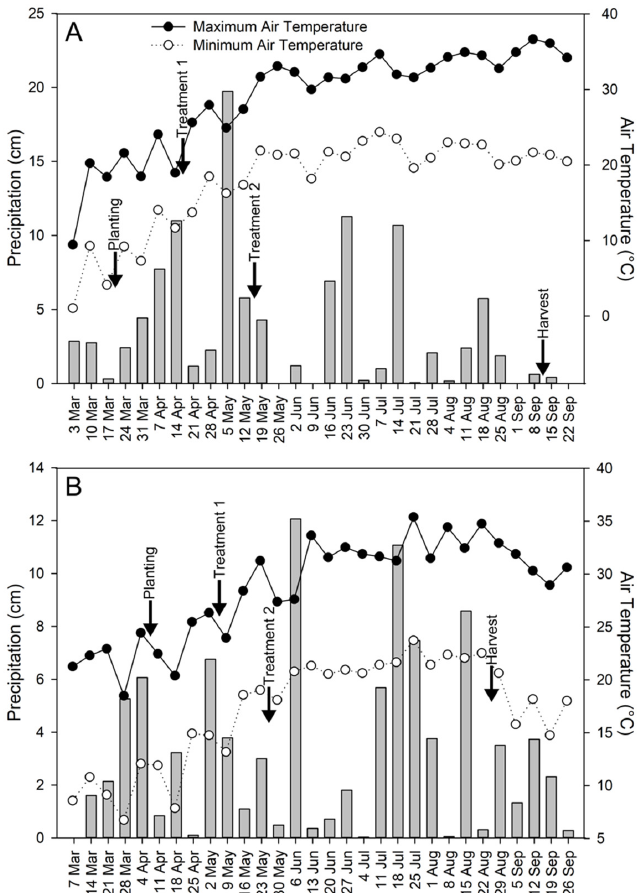
Figure 1. Weekly precipitation (bars), minimum air temperature (open circle), and maximum air temperature (closed circle) during the first ( A ) and second ( B ) study years. Times of sowing, herbicide treatments, and harvest are indicating by arrows.